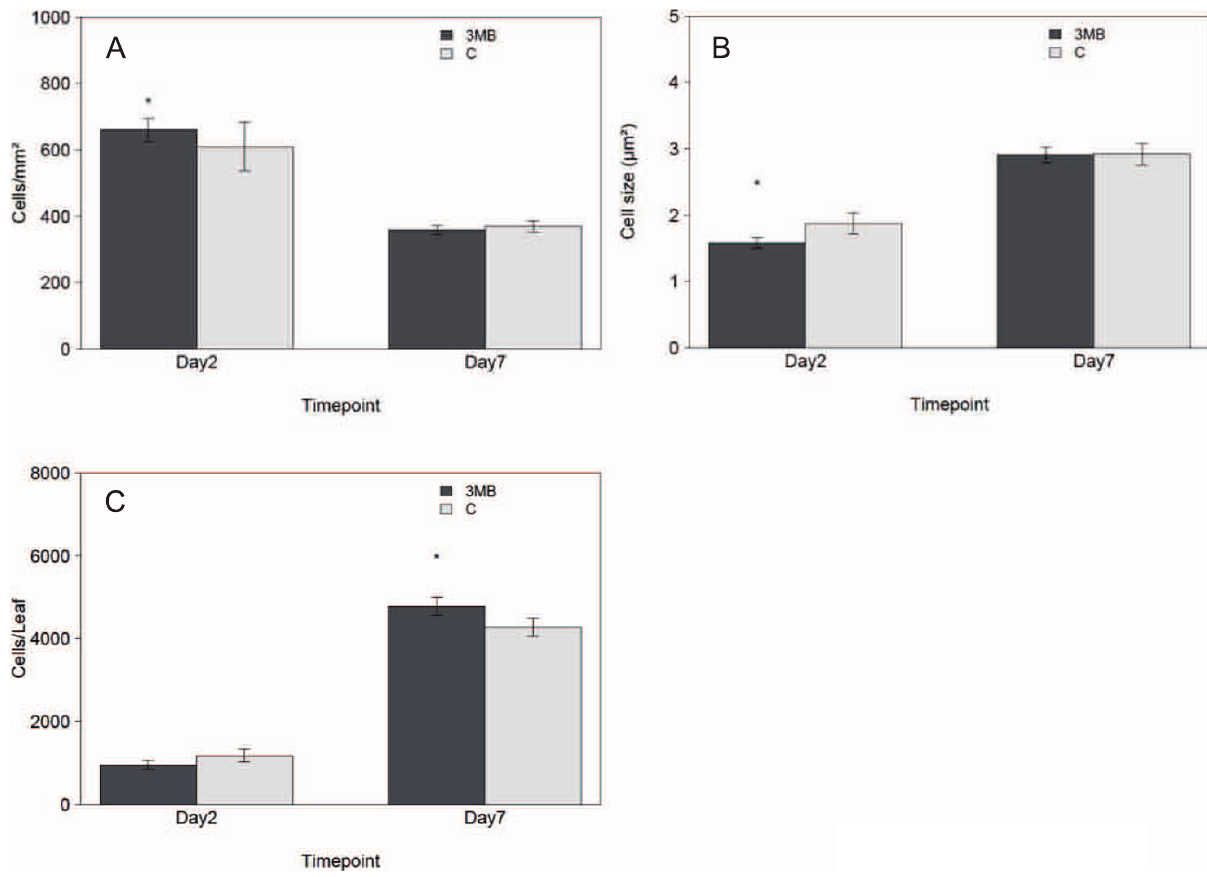
Figure 3. PARP inhibition induced cell number increase. Arabidopsis leaf two was analyzed after two days of transferring the seedlings (day2) or after seven days (day7) either to treatment or control conditions. (A) Cell number per mm 2 , (B) cell size in m m and (C) the calculated cell number per leaf is presented. Seedlings were previous grown for seven days in control conditions. In each experiment 4–6 leafs were analyzed and the experiment repeated three times independently (n=12–18). Significant differences (P , 0.05) between treated and untreated plants is indicated by an asterisk.